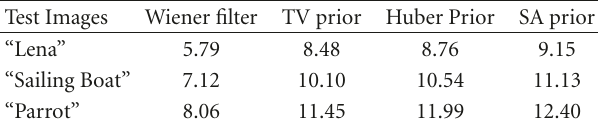
Table 4: Improvement in signal-to-noise ratio (ISNR) of the observed degraded images and the restored